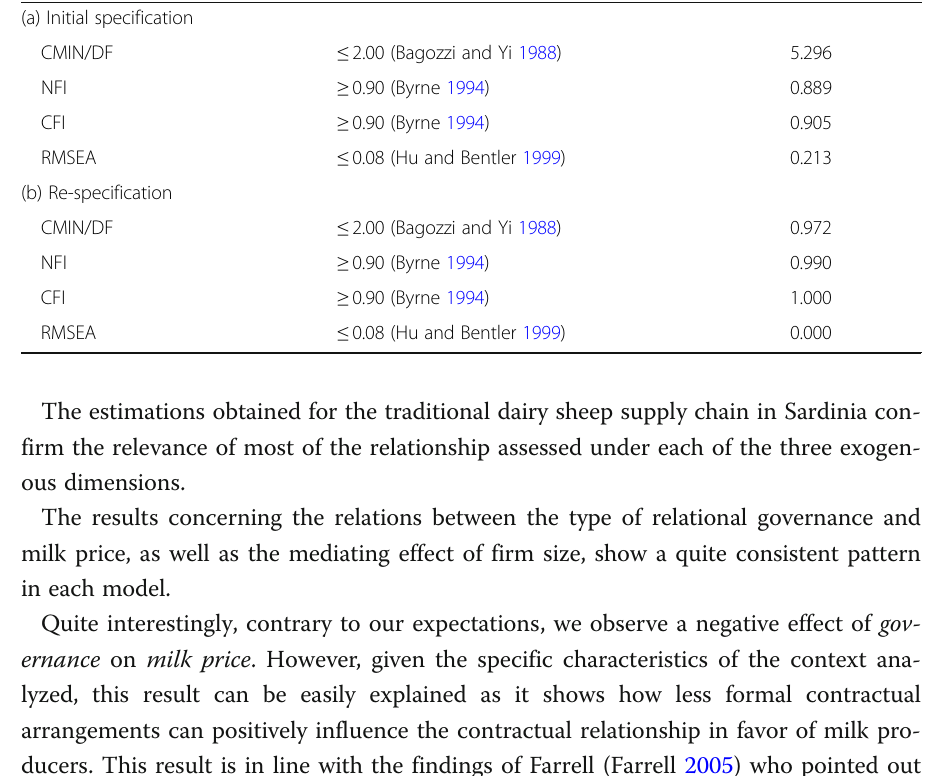
Table 8 H3 SEM model fit indicators Indicator Cut-off